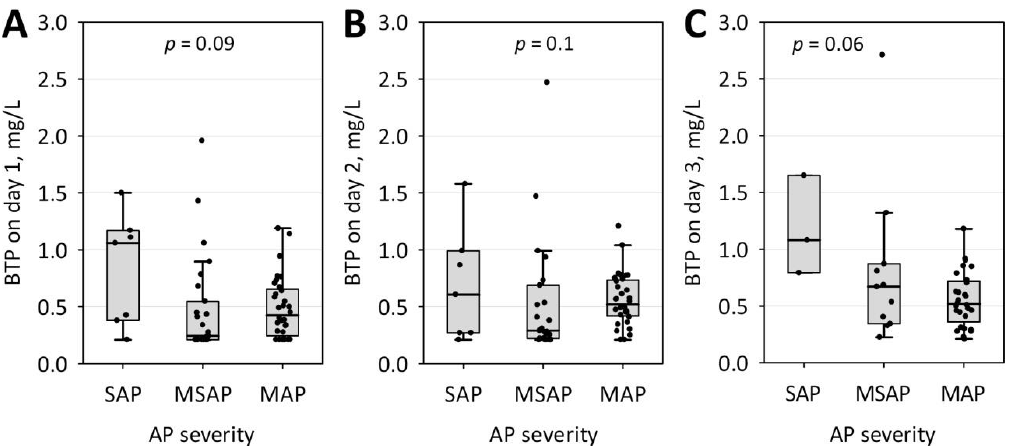
Figure 2. Serum BTP concentrations on day 1 ( A ), 2 ( B ) and 3 ( C ) of hospital stay among patients with acute pancreatitis (AP) of various severity (SAP, severe; MSAP, moderately severe; and MAP, mild) diagnosed according to the modified 2012 Atlanta classification. Data are shown as raw data (points), median (central line), interquartile range (box), and non-outlier range (whiskers). Strong positive correlations were observed over the studied period between serum BTP and other studied laboratory markers increasing in result of impaired renal filtration, i.e., serum